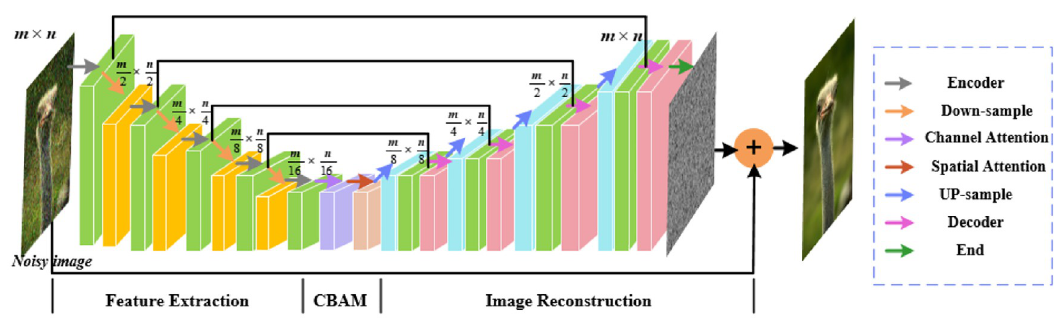
Fig 2. Model architecture of proposed DCNN denoiser. Right part is specific